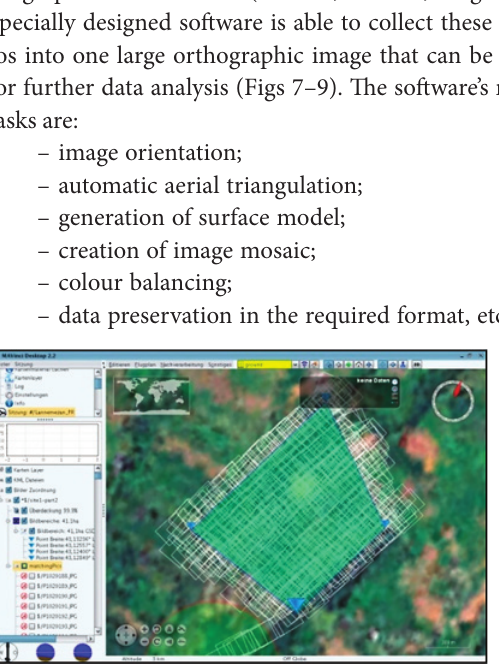
Fig. 7. Imported picture positions after the flight from MAVinci Desktop flight planning software (Images … 2011)